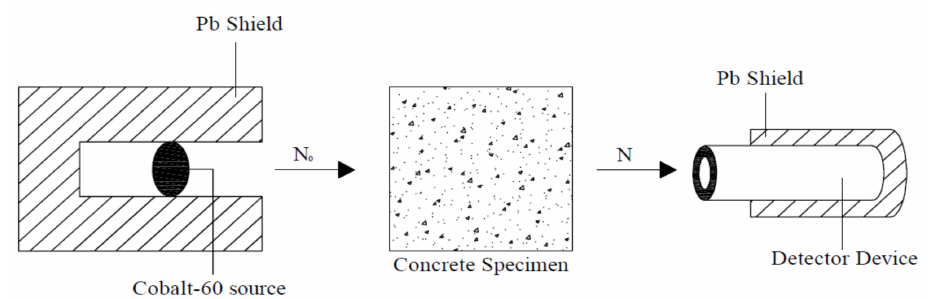
Figure 6. Gamma-ray transmission measurement test setup.